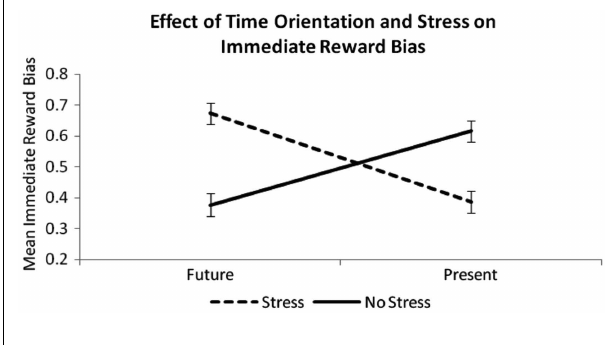
FIGURE 3 | Means of immediate reward bias (i.e., percentage of immediate options chosen) for each group (Future Stress, Future Non-stress, Present Stress, Present Non-stress). There is a significant interaction between time orientation manipulation and acute stress manipulation on this variable [ N = 112; F (1,111) = 56.63, p < 0.001], showing that future orientation increases choices for immediate reward when the stressor is present, but decreases immediate reward bias when the stressor is